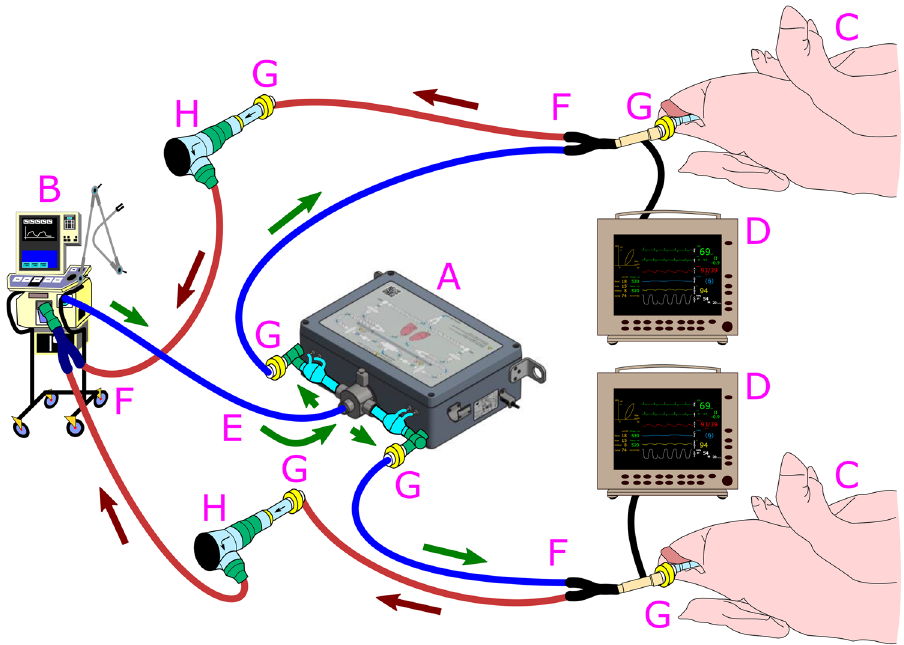
Figure 1. Ventilation of two pigs was performed with a Ventil and a ventilator. Animal experiment test stand. A, Ventil; B, ventilator or anesthetic machine; C, ventilated subject; D, patient monitor; E, adult polypropylene extendible limb 22F-22F; F, adult polypropylene anesthesia extendible breathing circuits with Y-pieces; G, antibacterial and antiviral filter; H, positive end-expiratory valve with one-way valve and set of connectors; green arrows—the flow direction during the inspiration; dark red arrows—the flow direction during the